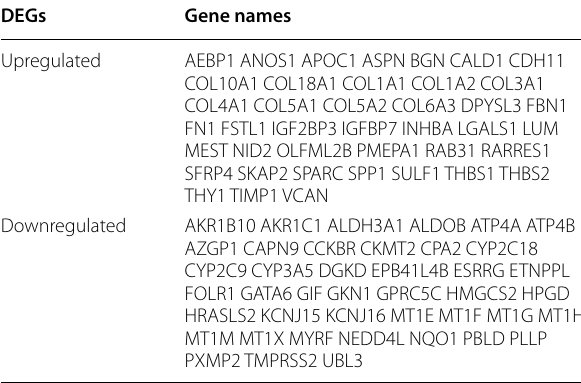
Table 2 Detected DEGs in gastric cancer by integrated microarray